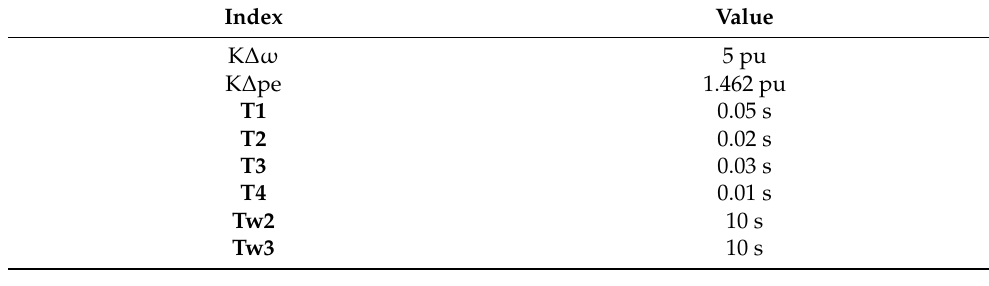
Table A1. Optimal control parameters.